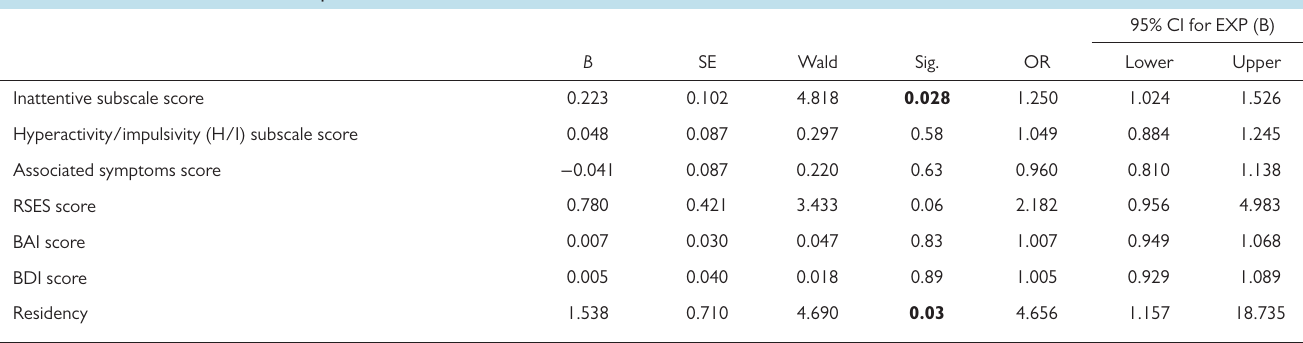
Table 4. Predictors of Suicidal Attempts in the Cohort